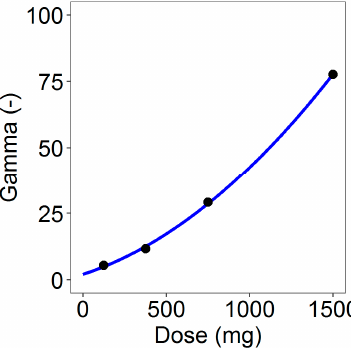
Figure 5. Fitted γ = γ ( DOSE ) curve describing the dependence of the in vitro–in vivo inhibitory Figure 5. Fitted 𝛾 = 𝛾(𝐷𝑂𝑆𝐸) curve describing the dependence of the in vitro–in vivo inhibitory factor on the dose. factor on the